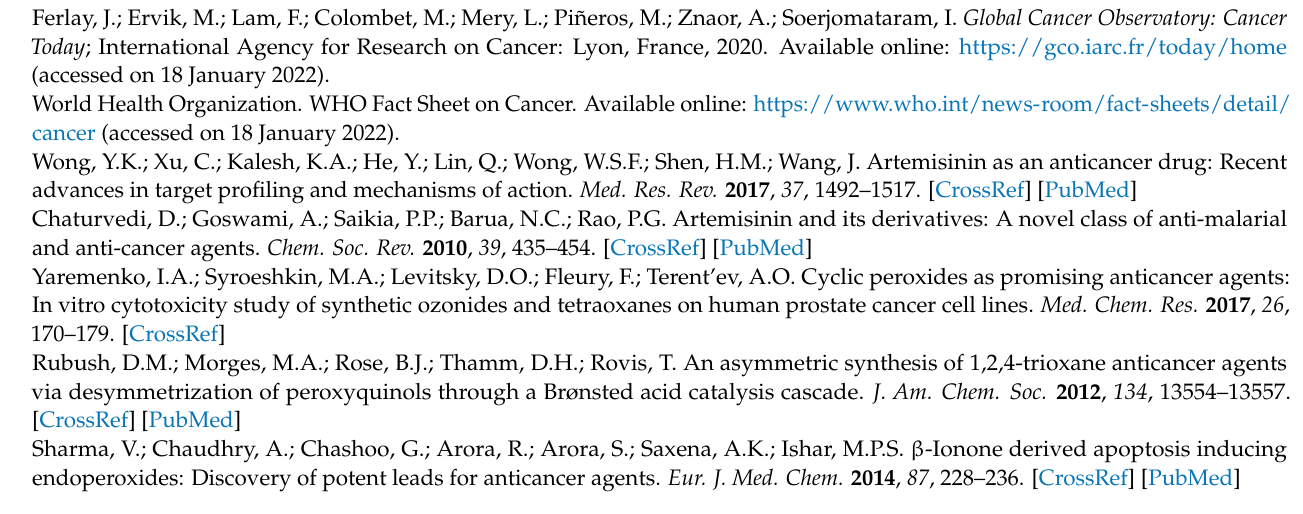
Figure S20: Validation of docking reliability by using the known crystallize X-ray structure of target protein P-gp complexed with Zosuquidar; Table S1: Cytotoxicity studies [37]; Table S2: Docking scores of synthesized compounds 7 and 8 against P-gp protein; Table S3: MM-GBSA result for 7 , 8 and artesunic